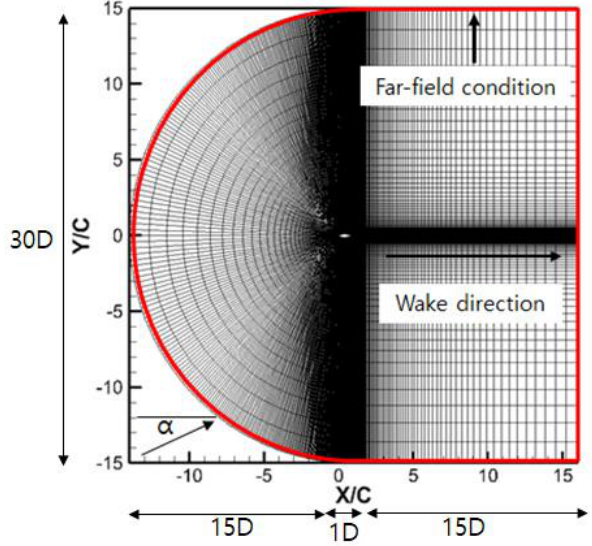
Figure 3. C-type grid topology used in this study, showing the overall grid resolution and boundary conditions.